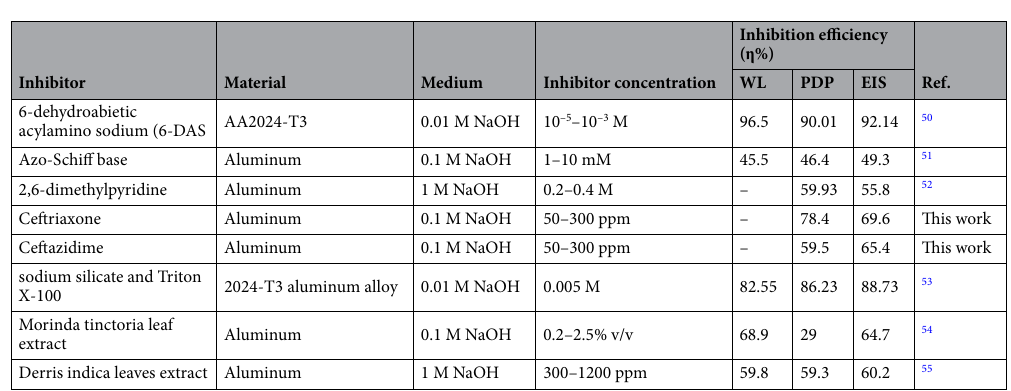
Table 5. The inhibition efficiency (η%) of Cefx and Cefz drugs on Al surface in 0.1 M NaOH solution compared to other organic inhibitors in NaOH solution. The inhibition efficiency (η%) listed in the table corresponds to the maximum values obtained in these